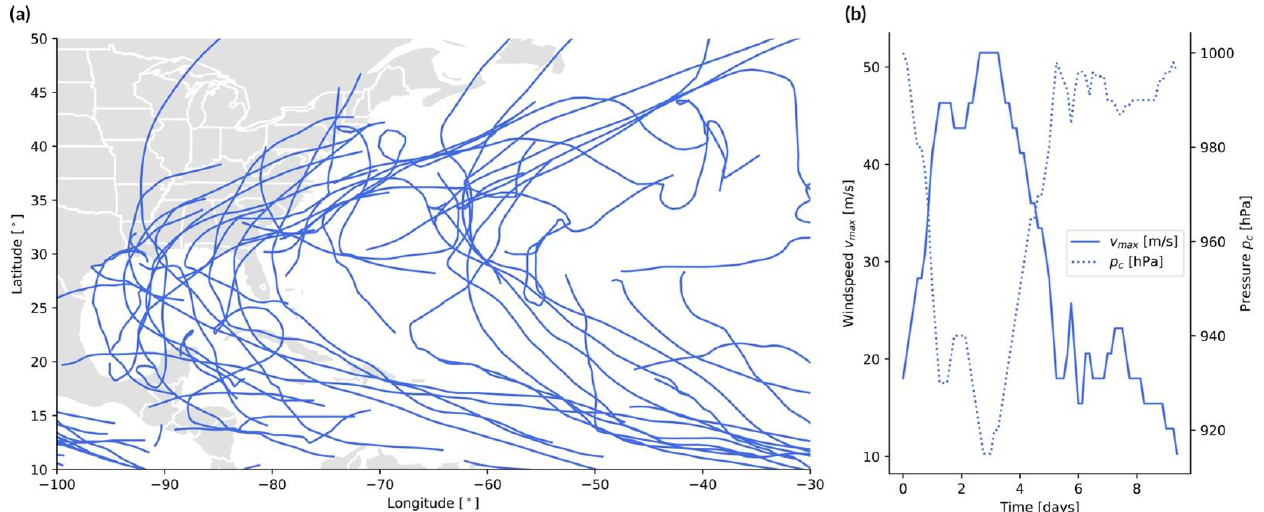
Figure 4. Example of track sources (tropical cyclone case). ( a ) Tracks of recent Atlantic hurricanes (2020 – 2022) in the IBTrACS database [48]; ( b ) windspeed 𝑣 𝑚𝑎𝑥 versus central pressure 𝑝 𝑐 along the track of 1992 ’s Typhoon Yvette, based on IBTrACS data as shown in [48].